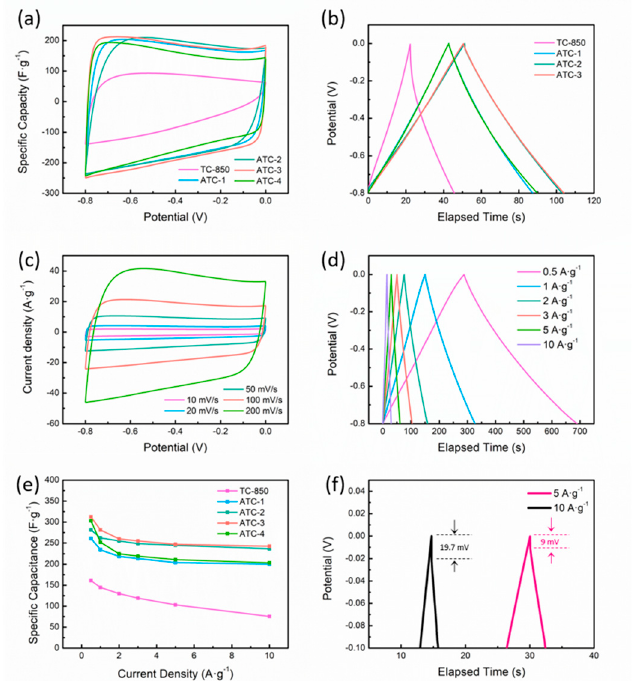
Figure 4. ( a ) CV curves of samples with and without activation at 50 mV·s − 1 ; ( b ) GCD curves of samples with and without activation at 3 A·g − 1 ; ( c ) CV curves of ATC-3; ( d ) GCD curves of ATC-3 at di ff erent current densities; ( e ) Specific capacitance of samples at growing current densities; ( f ) IR drop at high current